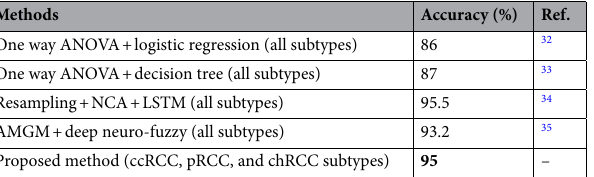
Table 3. Comparison of classification accuracy based on miRNA data. Significant values are in bold.